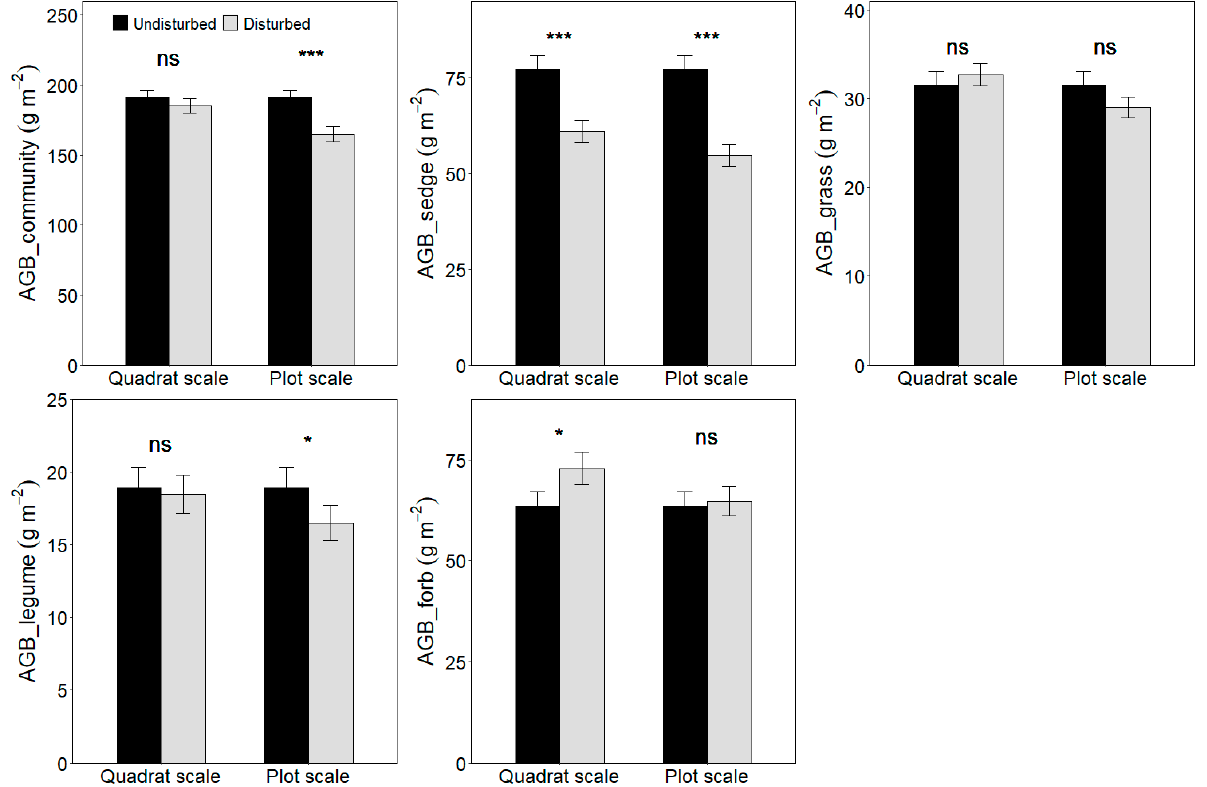
Figure 1. Effect of plateau pika disturbance on plant productivity of community and four functional groups at quadrat and plot scales (Mean ± Std. Error). ABG, aboveground biomass. The statistics were from the LMMs, with the paired plots nested within sites as random factors. For both quadrat and plot scales, ns means no significance between disturbed and undisturbed plots; * means significance between disturbed and undisturbed plots at p < 0.05; ***, means significance between disturbed and undisturbed plots at p < 0.001.